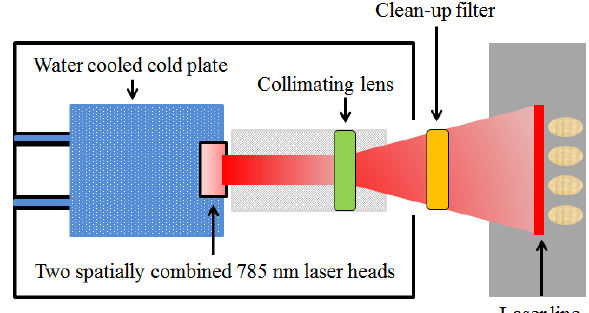
Figure 2. Line laser system used as the excitation source of the Raman hyperspectral imaging system.